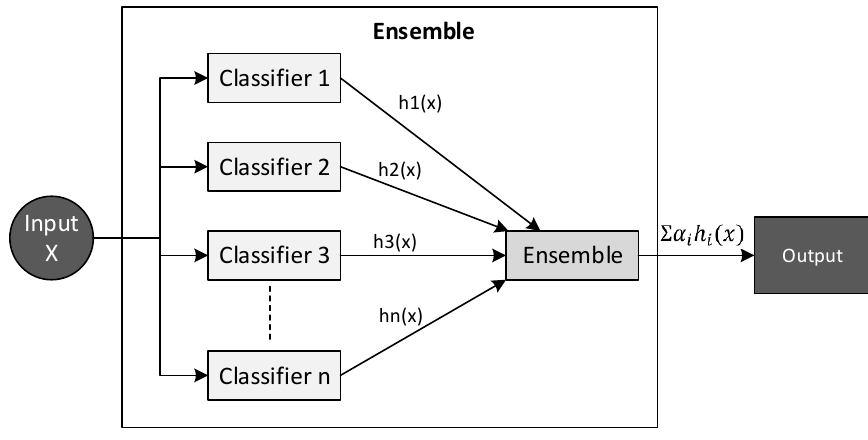
Figure 14. Working of an ensemble